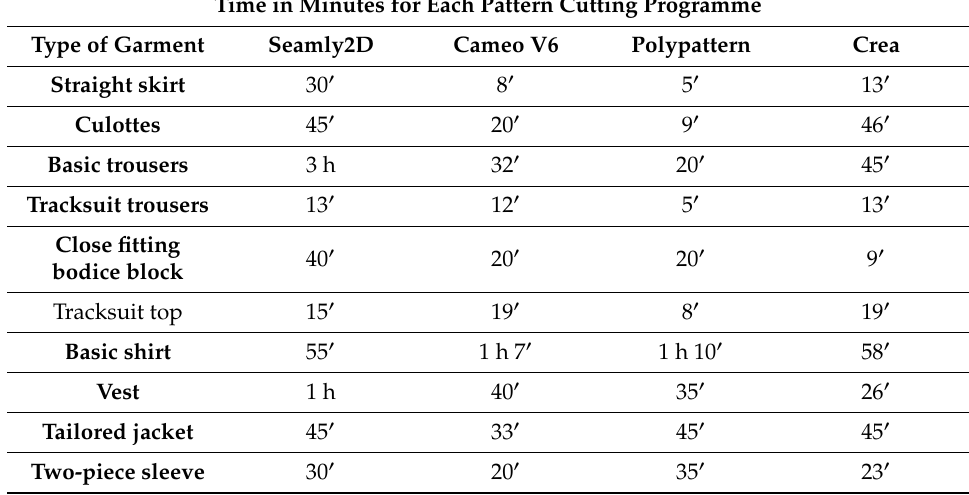
Table 1. Developing time for each style and each CAD